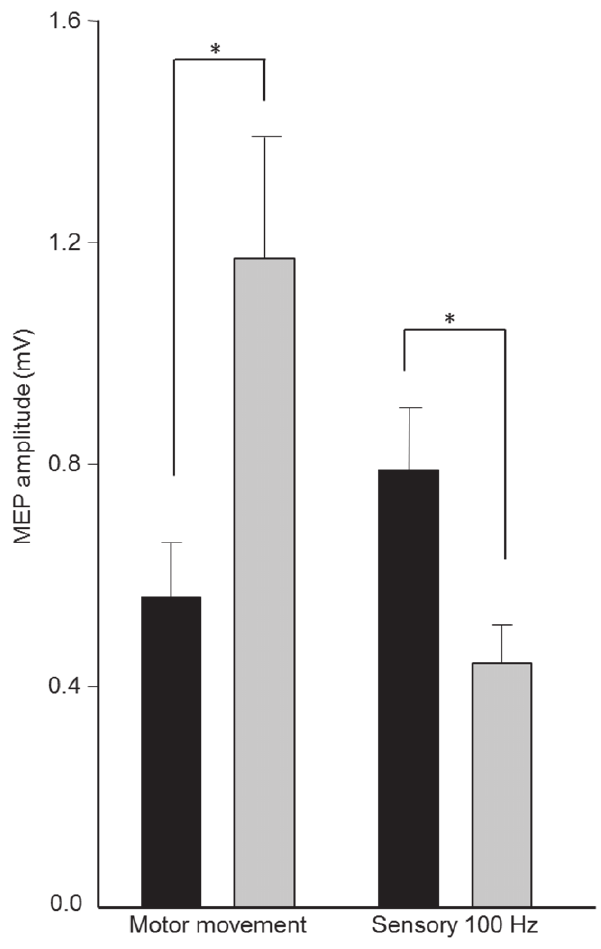
Figure 2. Group data (mean ± standard error) of amplitudes motor evoked potentials (MEP) before (black bars) and after (grey bars) ‘‘Motor Movement’’ and ‘‘Sensory 100 Hz’’ periph- eral electrical stimulation (PES) to right abductor pollicis brevis muscle (APB). MEP amplitude increased following Motor Movement PES and reduced following Sensory 100 Hz PES. * p , 0.05.